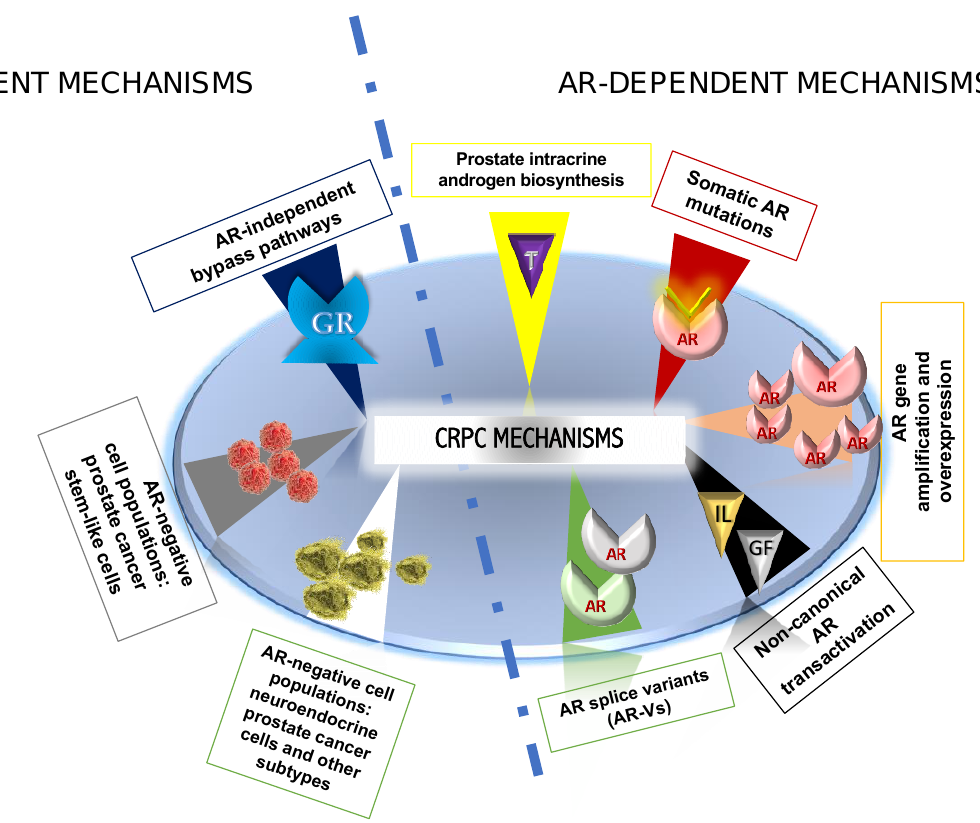
Figure 2. Mechanisms of resistance to androgen deprivation therapy. T, testosterone; AR, androgen receptor; IL, interleukin; GF, growth factor; GR, glucocorticoid receptor.